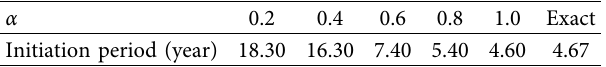
Table 1: Initiation period of corrosion under different α